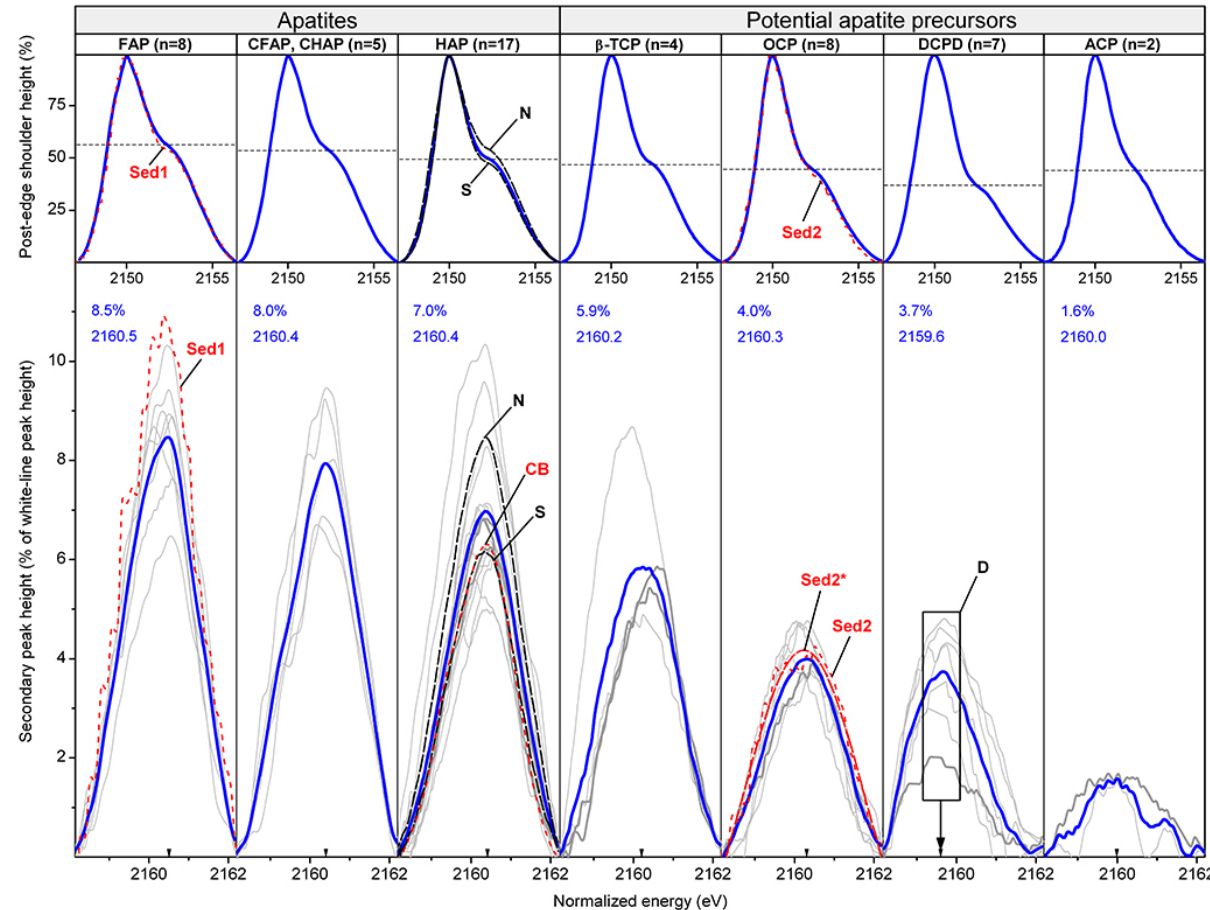
Fig. 4. Secondary peak heights and post-edge shoulder heights in percentages of white-line peak heights for P K-edge XANES spectra of different Ca-P species. Peak-height percentages of µXANES data of sediment particles (Brandes et al., 2007) indicate apatite (Sed1) and OCP (Sed2). The apparent OCP peak is different from DCPD due to its different peak position as indicated by a Gaussian Fit (Sed2*; cf. position with D). Individual spectra collected in fluorescence yield and total electron yield mode are shown for secondary peaks by thin and thick grey lines, respectively. Thick blue lines indicate averages for multiple standard curves ( n ), for which average secondary peak-height percentages and average secondary peak positions (eV) are indicated. Multiple natural (N; average of five spectra) and synthetic (S; average of eight spectra) HAP specimens contribute to the total average of the secondary HAP peak ( n = 17; precise source of four HAP specimens unknown). Secondary peaks of averaged spectra for six calcined bone apatites (CB; not included in the total HAP average) and synthetic HAP (S) match almost perfectly. FAP: fluorapatite; CFAP: carbonate fluorapatite; CHAP: carbonate hydroxylapatite; HAP: hydroxylapatite; β -TCP: β -tricalcium phosphate; OCP: octacalcium phosphate; DCPD: dicalcium phosphate dihydrate or brushite; ACP: amorphous calcium